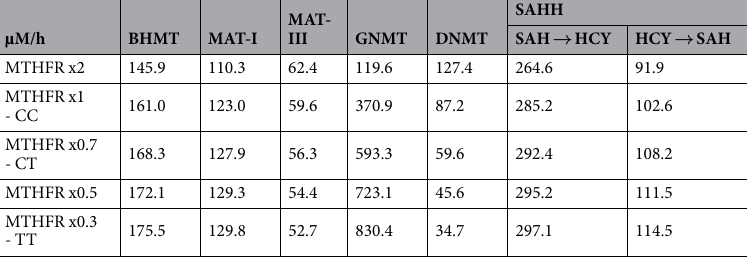
Table 5. Fluxes of the reactions catalyzed by the enzymes MTR, BHMT, MAT-I, MAT-III, GNMT, DNMT and SAHH for different levels of MTHFR activity (ranging from 2x to 0.3x of wild type). CC, CT and TT refer to the C667T polymorphism.